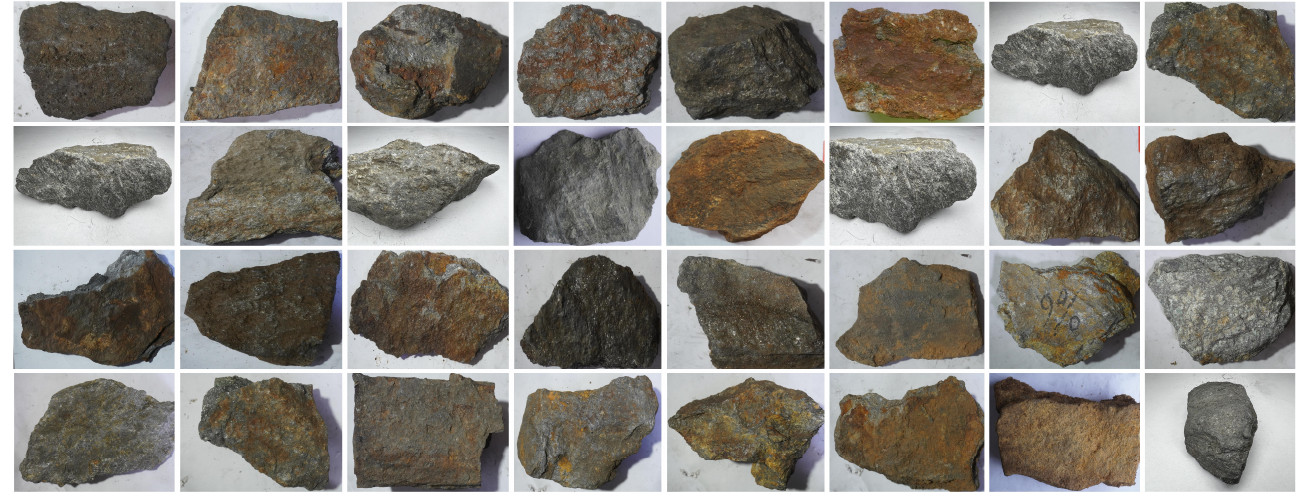
Figure 2. A small portion of the original ore stone images data.